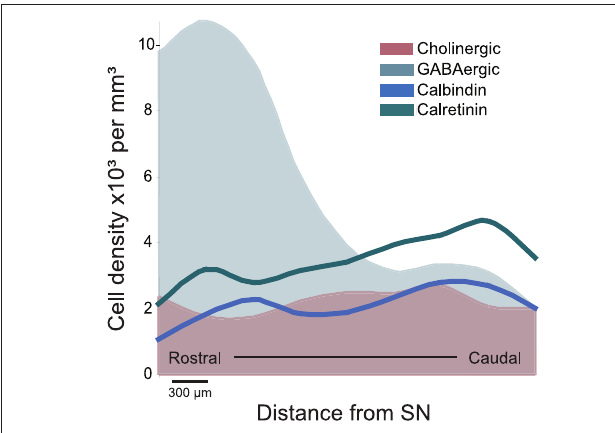
Figure 1 | Schematic representation of the distribution of distinct neuronal populations in the PPN. GABAergic neurons are highly concentrated in the rostral PPN, whereas cholinergic, glutamatergic (not shown), calbindin- and calretinin-expressing neurons are more abundant in the caudal PPN. The PPN was divided into 300 μm segments and cell density was evaluated throughout its rostro-caudal extent (Martinez-Gonzalez et al., 2009; Mena-Segovia et al., 2009). The difference in the rostro-caudal distribution of GABAergic neurons correlates with the differences in cytoarchitecture of the cholinergic neurons traditionally used to identify PPN regions (i.e., pars dissipata and pars compacta ). As shown in this figure, the rostral PPN is an area of high neuronal density. SN,